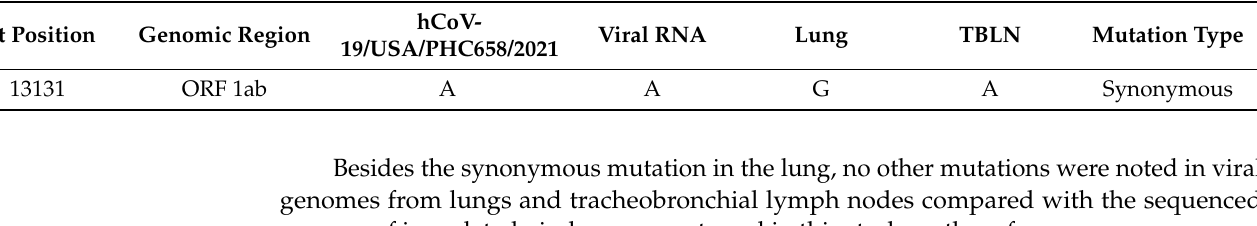
Table 3. A synonymous mutation was detected in ORF 1ab at nucleotide position